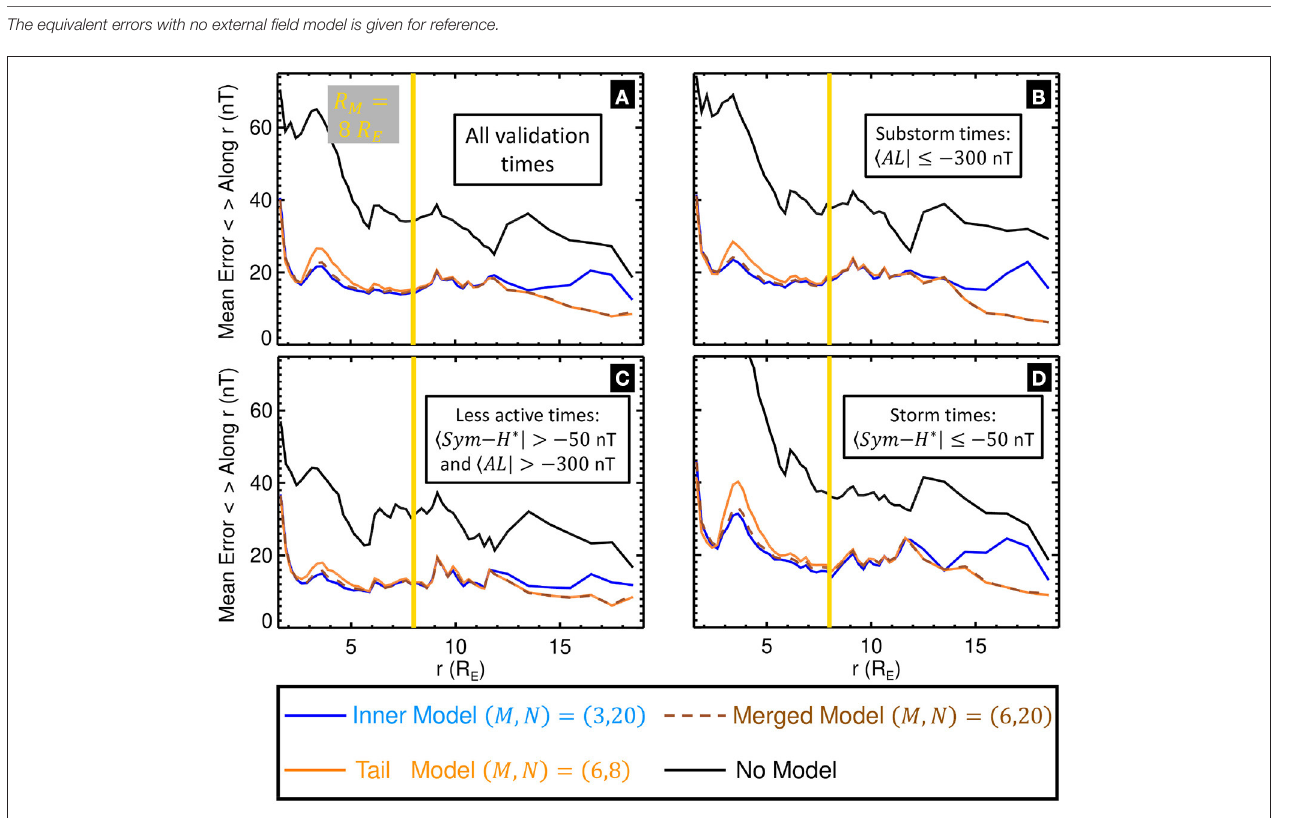
ǫ computed in different radial bins for the Inner Model (blue lines), Tail Model h i > > 300 nT, (C) less active times 50 and 300 nT, AL Sym-H ∗ AL h | ≤ − h | − h | − 50 Sym-H ∗ h | ≤ −